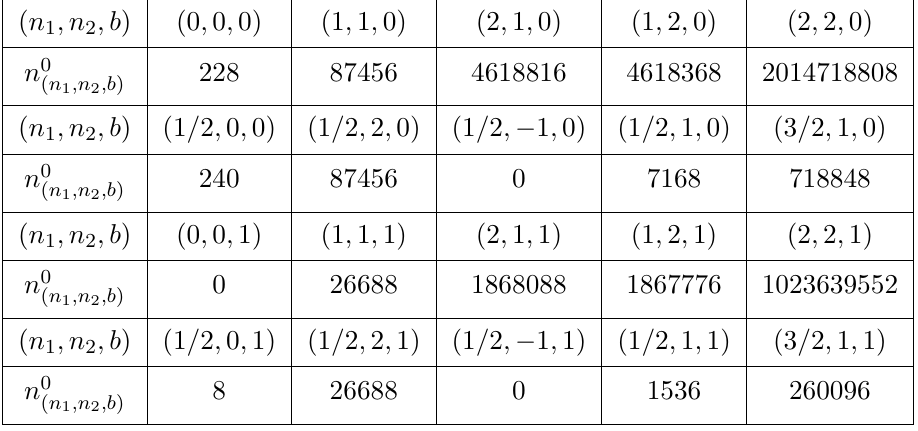
Table 13 . 2 A orbifold, non-standard embedding, with single Wilson line. Shift is given by, (cid:13)